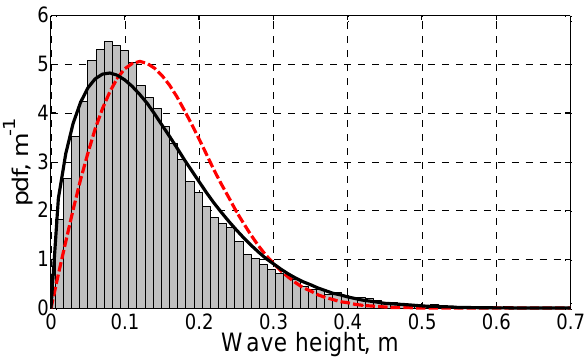
wakes from a) “SuperStar” (18 June 2009, 16:15), b) “Star” (20 June 2009, 12:10). The averaged distributions of wave heights within the vessel wake computed by the up- crossing method are demonstrated in Figs. 4 and 5. The averaging was performed over all 66 recorded events (Fig. 4) and for each specific ship which has crossed the bay several times during the time of the observations (Fig. 5). The average distribution gathering the data from all ships might be reasonable, since all studied vessels are characterized by similar lengths, widths, draughts and operational speeds and induce similar wave wakes, and, therefore, can be considered as an averaged wake wave height distribution. It can be seen that most of wave heights are distributed within the interval <30 cm and the number of particularly high waves in the wake is rather low. For example, the waves whose heights are larger than 40 cm constitute just 2% of the wave heights within one wake. For wakes from different vessels it varies from 1%